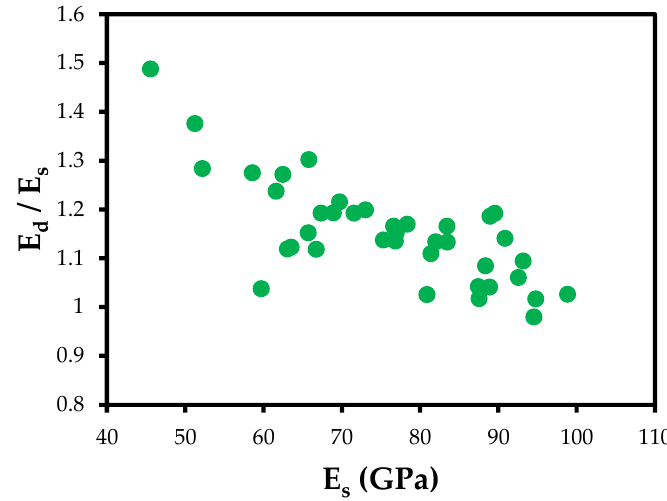
Figure 4. Comparison of static and dynamic Young’s modulus for prasinites.